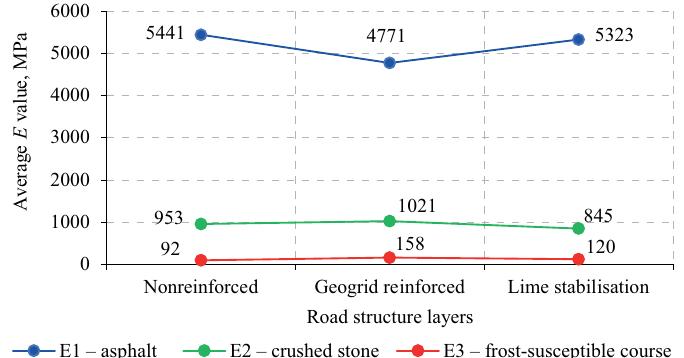
Figure 8. Average values of bearing capacity in the national road No. 131 (52.45–57.12 km)